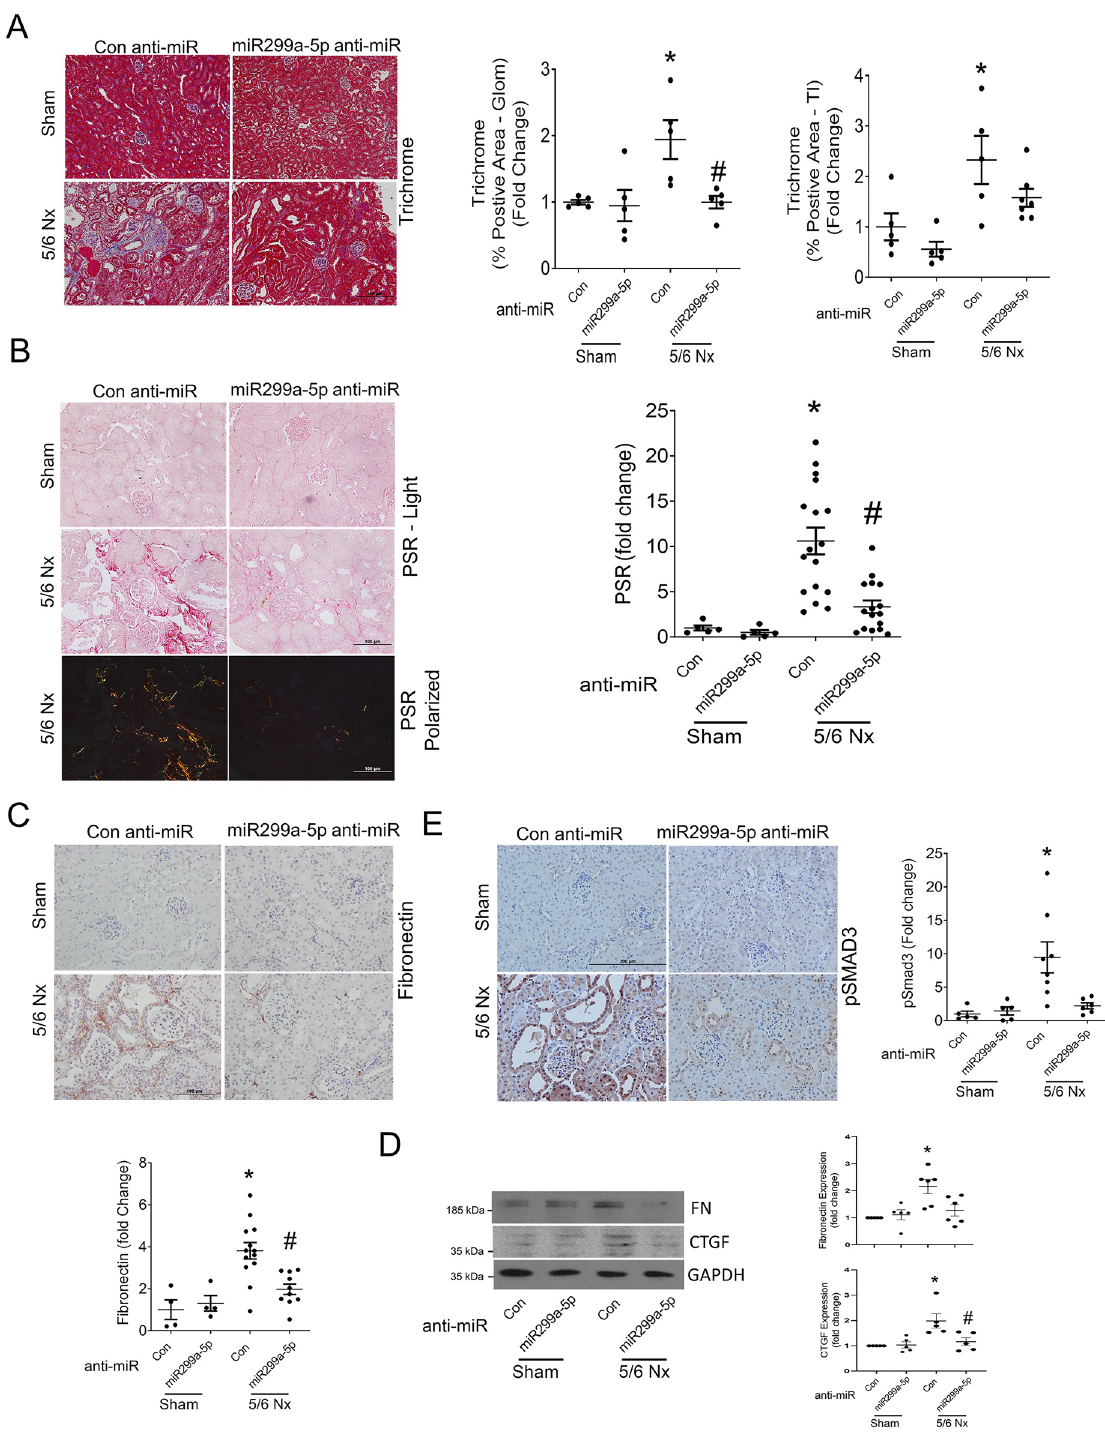
Figure 7. miR299a-5p inhibition reduced renal fibrosis in mice with CKD. CKD mice exhibited extensive glomerular sclerosis and tubulointerstitial fibrosis, as assessed by trichrome (glomerular (glom) and tubular interstitial (TI) areas quantified) ( A ) and PSR ( B ) staining, fibronectin immunohistochemistry ( C ), and fibronectin and CTGF immunoblotting ( D ) all of which were improved by miR299a-5p anti- miR administration. ( E ) Elevated renal Smad3 signaling in mice with CKD, assessed using pSmad3 immunohistochemistry, was improved by miR299a-5p anti-miR administration (*vs Sham-Con-anti-miR, #vs 5/6 Nx-Con anti-miR, p < 0.05 by t-test, scale bar = 100 μm or 200